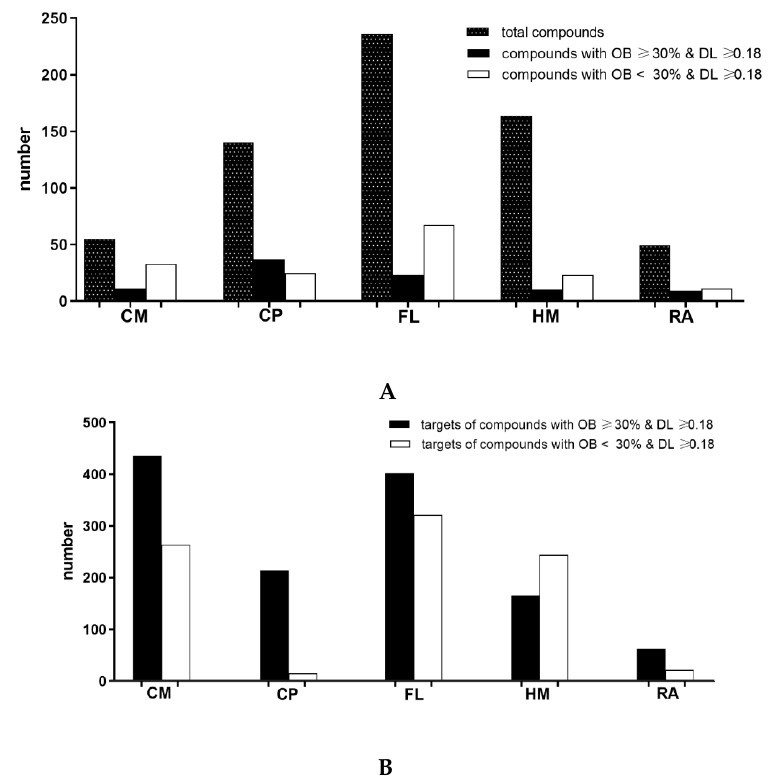
Figure 1. The counting of ( A ) compounds and ( B ) putative targets in the Pentaherb Formula. OB: oral bioavailability; DL: drug-likeness; CM: Cortex Moutan; CP: Cortex Phellodendri; FL: Flos Lonicerae; HM: Herba Menthae; RA: Rhizoma